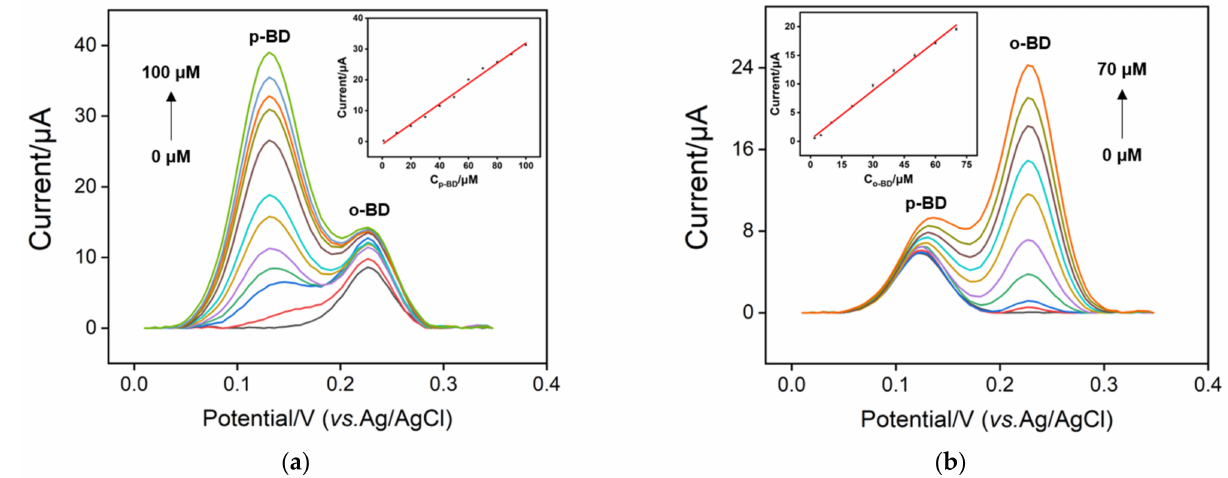
Figure 7. ( a ) DPV responses of p-3DG electrode to various concentrations of p-BD in presence of o-BD (20 µ M). ( b ) DPV responses of p-3DG electrode to various concentrations of o-BD in presence of p-BD (20 µ M). Table 1. Determination of p-BD in pond water sample in the presence of o-BD.